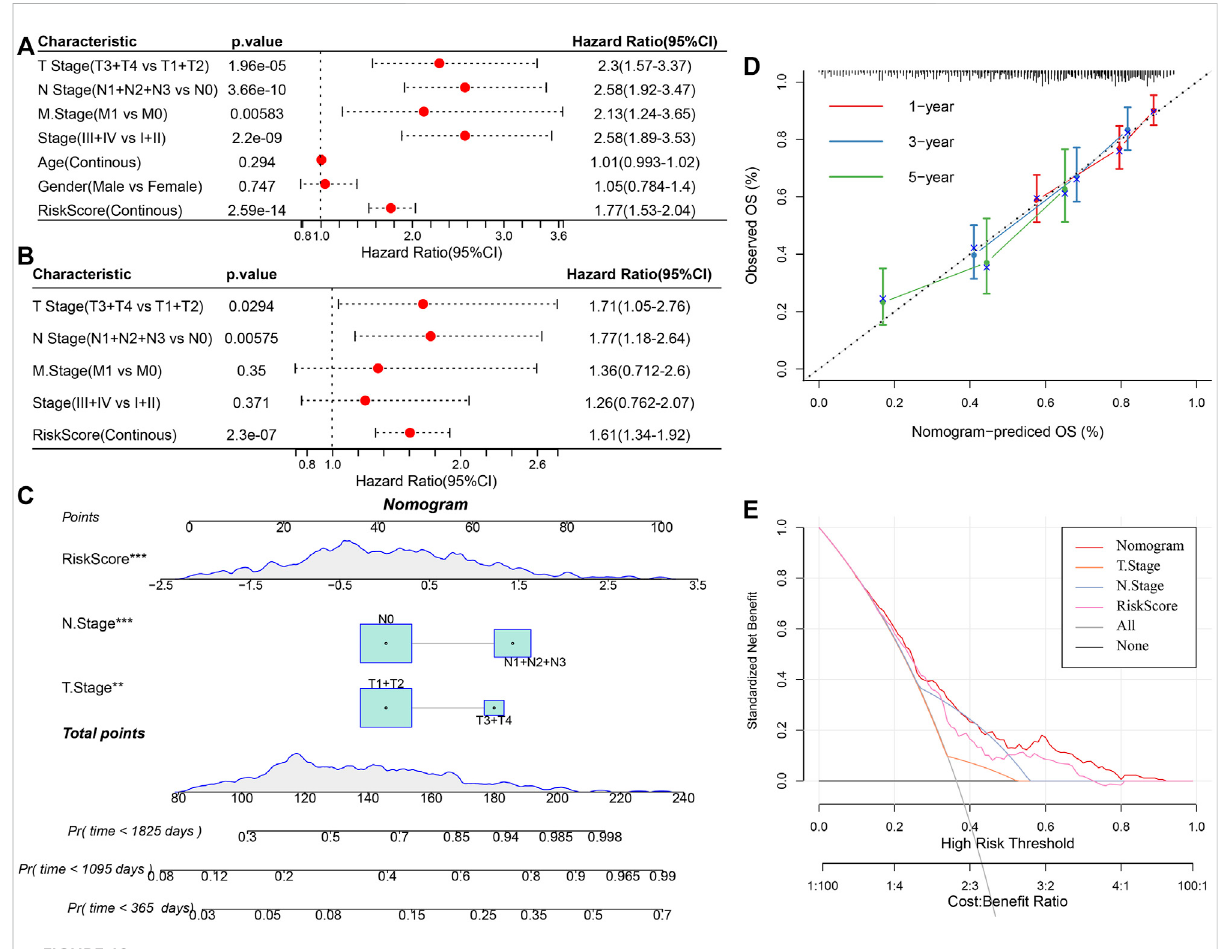
Improvement of prognosis model and survival prediction. (A,B) univariate and multivariate Cox analysis of RS and clinicopathological characteristics; (C) Nomogram model; (D) Calibration curve of nomogram in 1, 3, and 5 years; (E) Decision curve of the